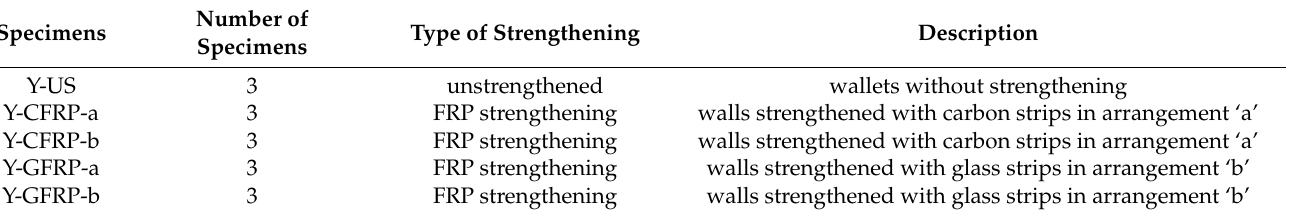
Table 3. Summary and designations of all test